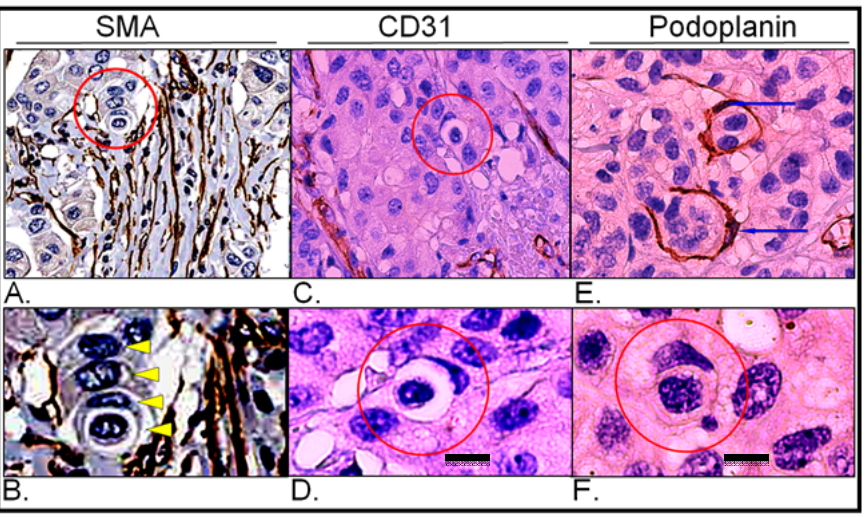
Figure 8. Expression of vascular markers in the primary lesion and lymph node metastasis; ( A ) Primary lesion: smooth muscle actin immunohistochemistry; the red circle indicates a multicell entotic figure; histological scan. ( B ) Primary lesion: smooth muscle actin immunohistochemistry; the yellow arrowheads display particular cells within a multicell entotic figure; digital magnification of panel A. ( C ) Primary lesion: CD31 immunohistochemistry; the red circle indicates entotic figures; 10 × microscope objective. ( D ) Primary lesion: CD31 immunohistochemistry; view of selected entotic figure; 40 × microscope objective. ( E ) Lymph node metastasis: podoplanin immunohistochemistry; the blue arrows indicate nuclei of lymph vessels; 10 × microscope objective. ( F ) Lymph node metas- tasis: podoplanin immunohistochemistry; the red circle indicates entotic figure; 40 × microscope objective. Scalebar 10 µ